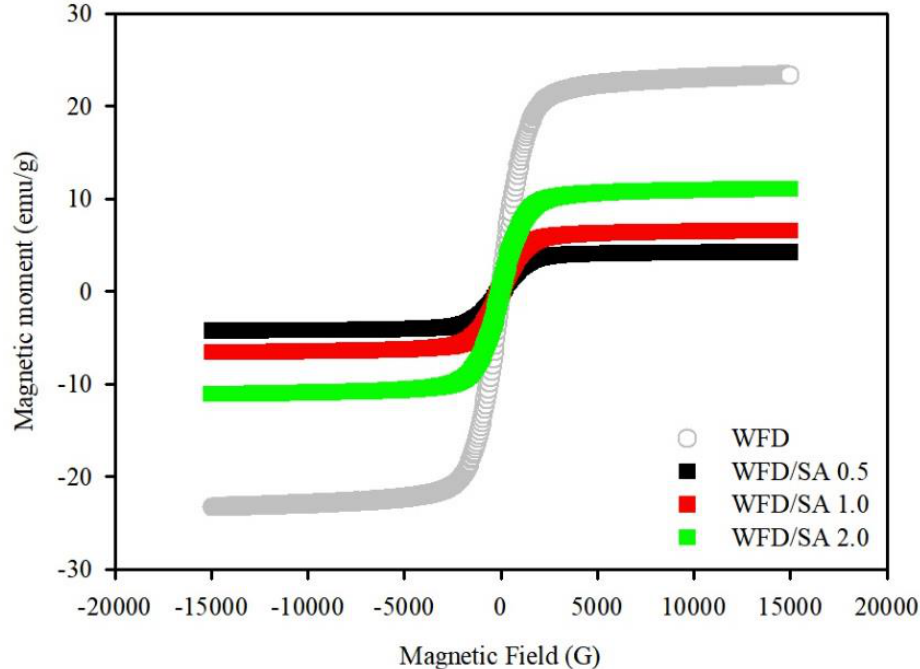
Figure 4. Magnetization curves of WFD and WFD/SA bead (different mass ratios of WFD).